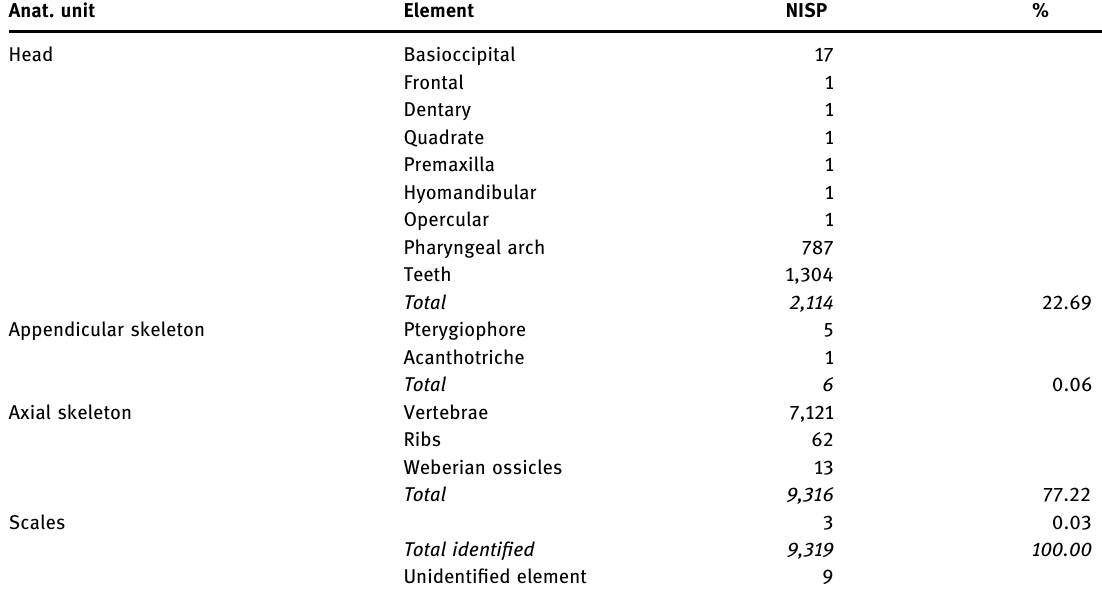
Table 4: Relative abundance ( NISP ) of fi sh skeletal elements grouped by anatomic unit ( % ) – Ranchot Layer 3 assemblage ( complete sample, all taxa ) Anat.